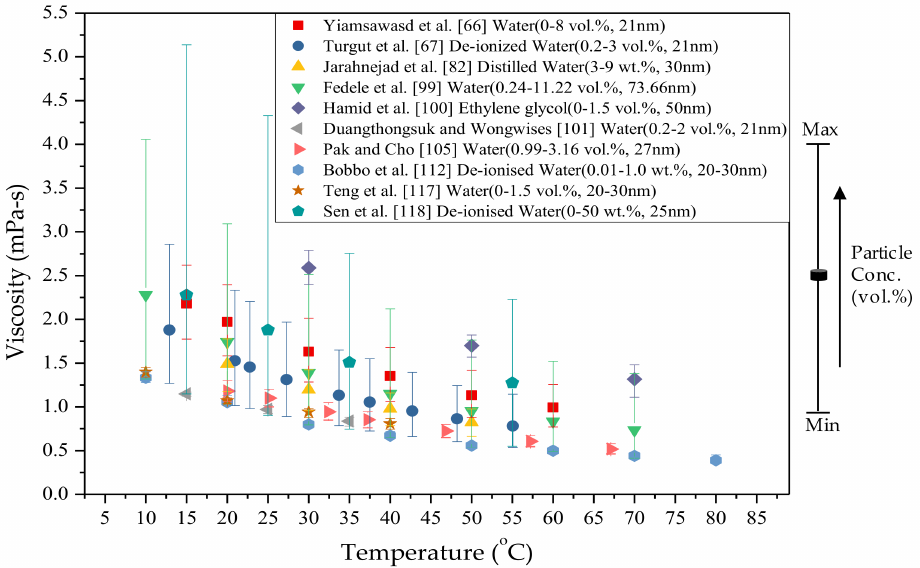
Figure 18. Viscosity of TiO 2 nanofluid as a function of temperature [Various studies].